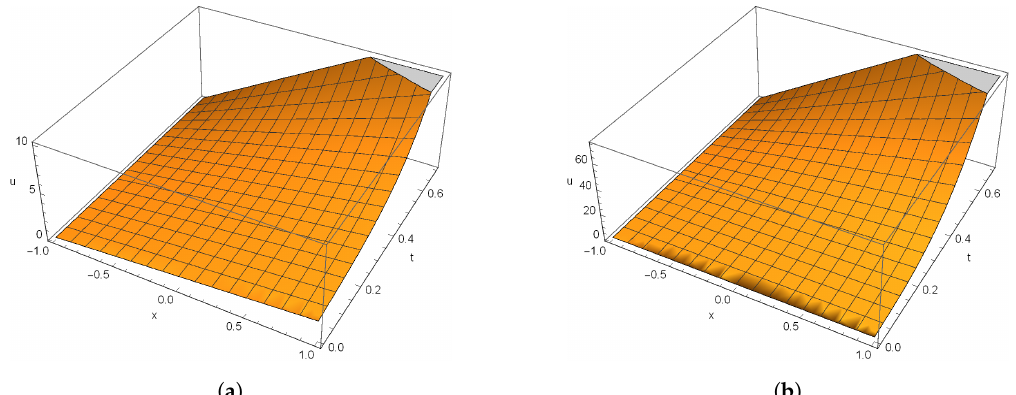
Figure 6. The seventh order approximation u 7 for (a) α = 0.8 and (b) α = 0.5; y = 0.5, z = 0.5.